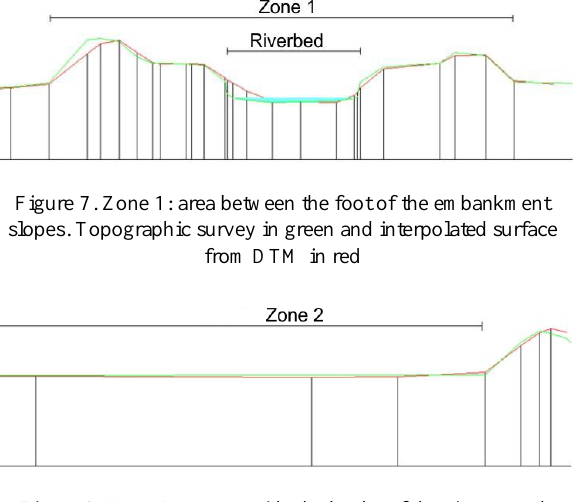
Figure 8. Zone 2: area outside the banks of the river. Land topographically surveyed in green and interpolated surface from DTM in red Such observations are also quite obvious in the planimetric representation of Figure 9, and point out a lower degree of reliability of elevation models to describe riverside areas in general.